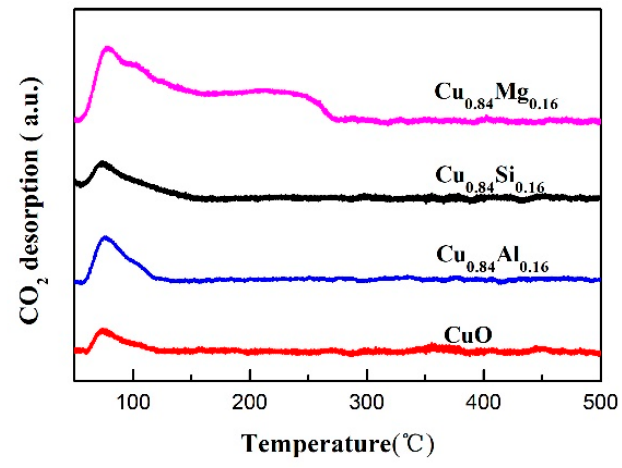
Figure 5. CO 2 - temperature-programmed desorption (TPD) profiles of the catalysts.